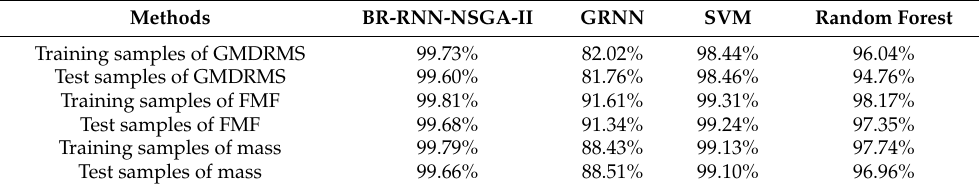
Table 6. MPA comparison of reflector design indexes prediction methods.